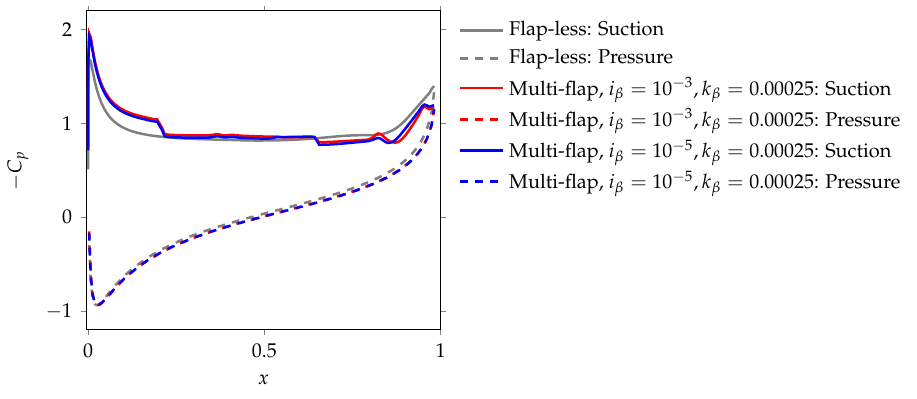
Figure 12. Mean C p distribution on the airfoil surface.